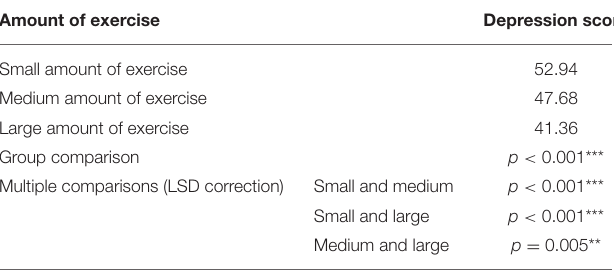
TABLE 3 | Effect of different exercise amount on depression of college students. Amount of exercise Small amount of